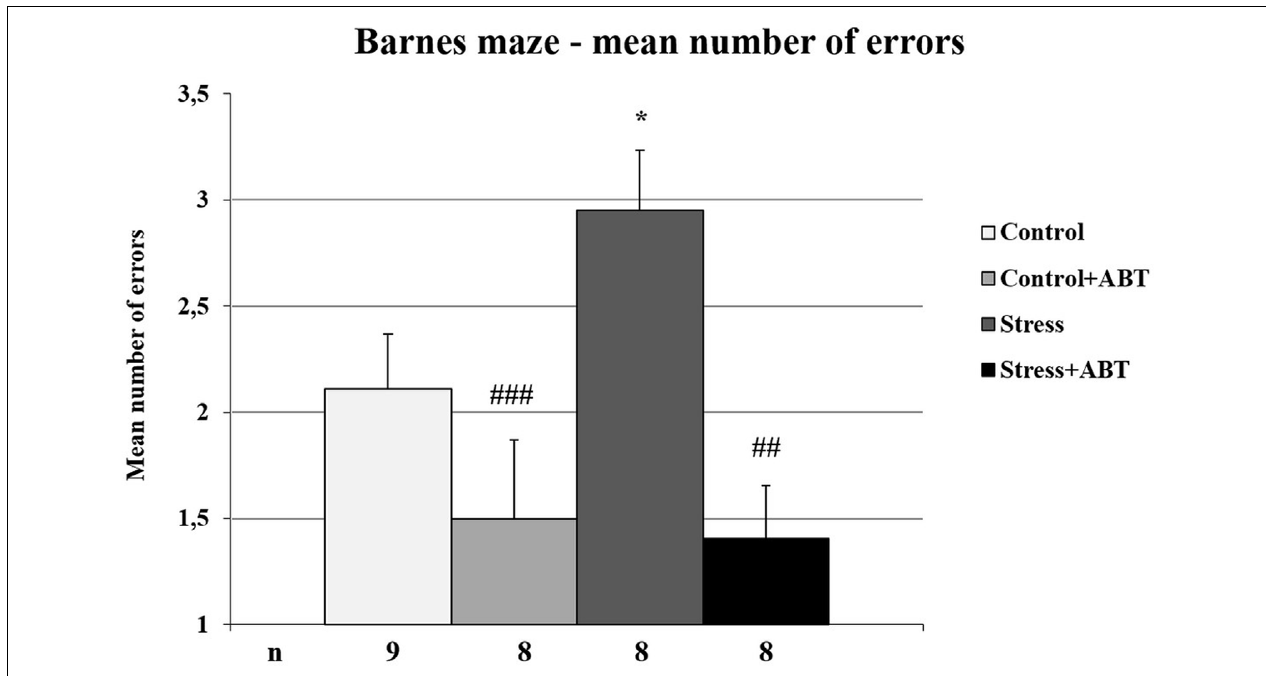
FIGURE 7 | Effects of chronic stress, prolonged ABT pre-treatment on performance in working memory test of the BM task. Each column represents the mean ± SEM number of errors from 12 trials (two trials per day for 6 days) obtained from n rats indicated at the bottom of the figure. The three groups demonstrated significantly different results in time to escape in comparison with Stress: vs. Control (* p < 0.05); vs. Control + ABT ( ## p < 0.01) and vs. Stress + ABT ( ### p <